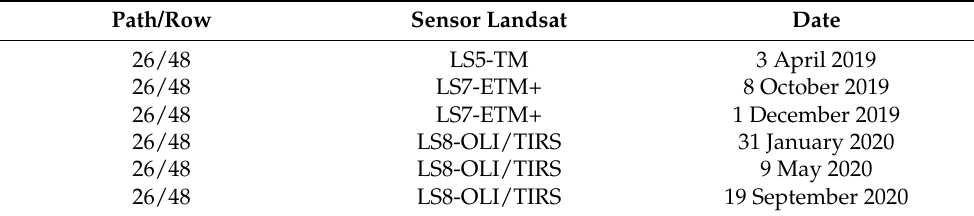
Table 3. General characteristics of the satellite images used in this study.